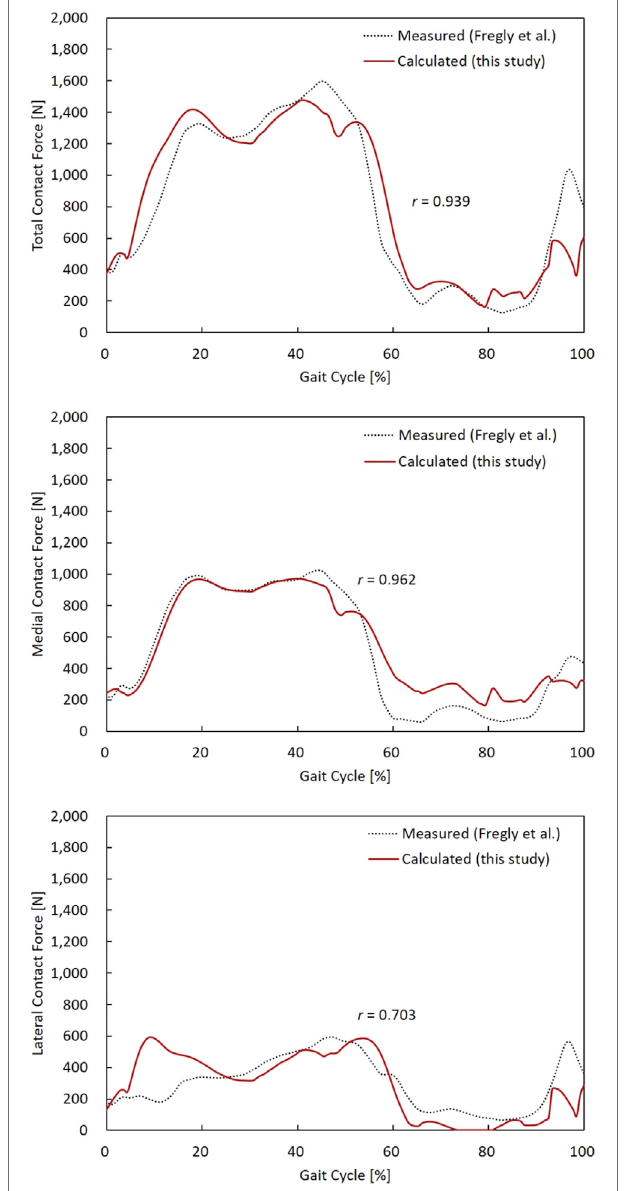
FIGURE 4 | TCF, MCF, and LCF calculated from the model, and the measured data were compared during a gait cycle. Pearson ’ s correlation coef fi cient (r) for TCF, MCF, and LCF were 0.939, 0.962, and 0.703, respectively. ( Figure 8 ). Six DOFs were all calculated for the femoral coordinate system with respect to the tibial coordinate system. The maximum fl exion angle difference between alignment/laxity models and the neutral alignment model was less than 1 ° ( Figure 8A ). Maximum posterior translation in the varus/valgus alignment and medial/lateral laxity models increased compared to the neutral alignment model ( Figure 8D ). Varus alignment models translated more laterally, while the valgus alignment model translated more